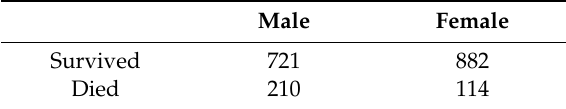
Table 3. Contingency table for effect of sex on survival, with male dogs showing 22.6% more fatalities than female dogs as measured in the Animal Records data (N = 1957; 2016 – 2020).